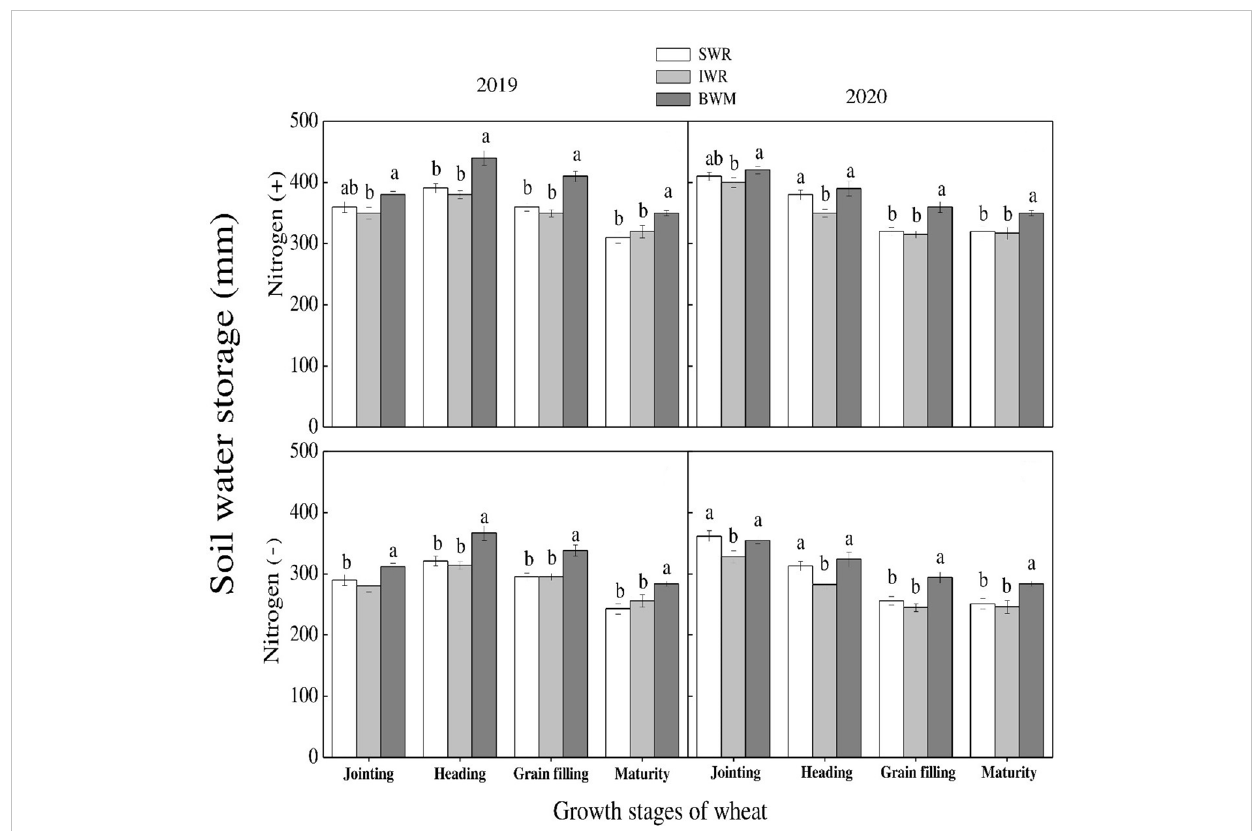
FIGURE 12 Soil water storage under sole wheat row (SWR), intercropped wheat row (IWR), and the rows between the intercropped strips of both crops (BWM) at various growth stages under with and without N application. Different letters on the top of each bar indicate signi fi cant differences among the various crop growth stages of wheat, as calculated by Tukey ’ s HSD test at P ≤